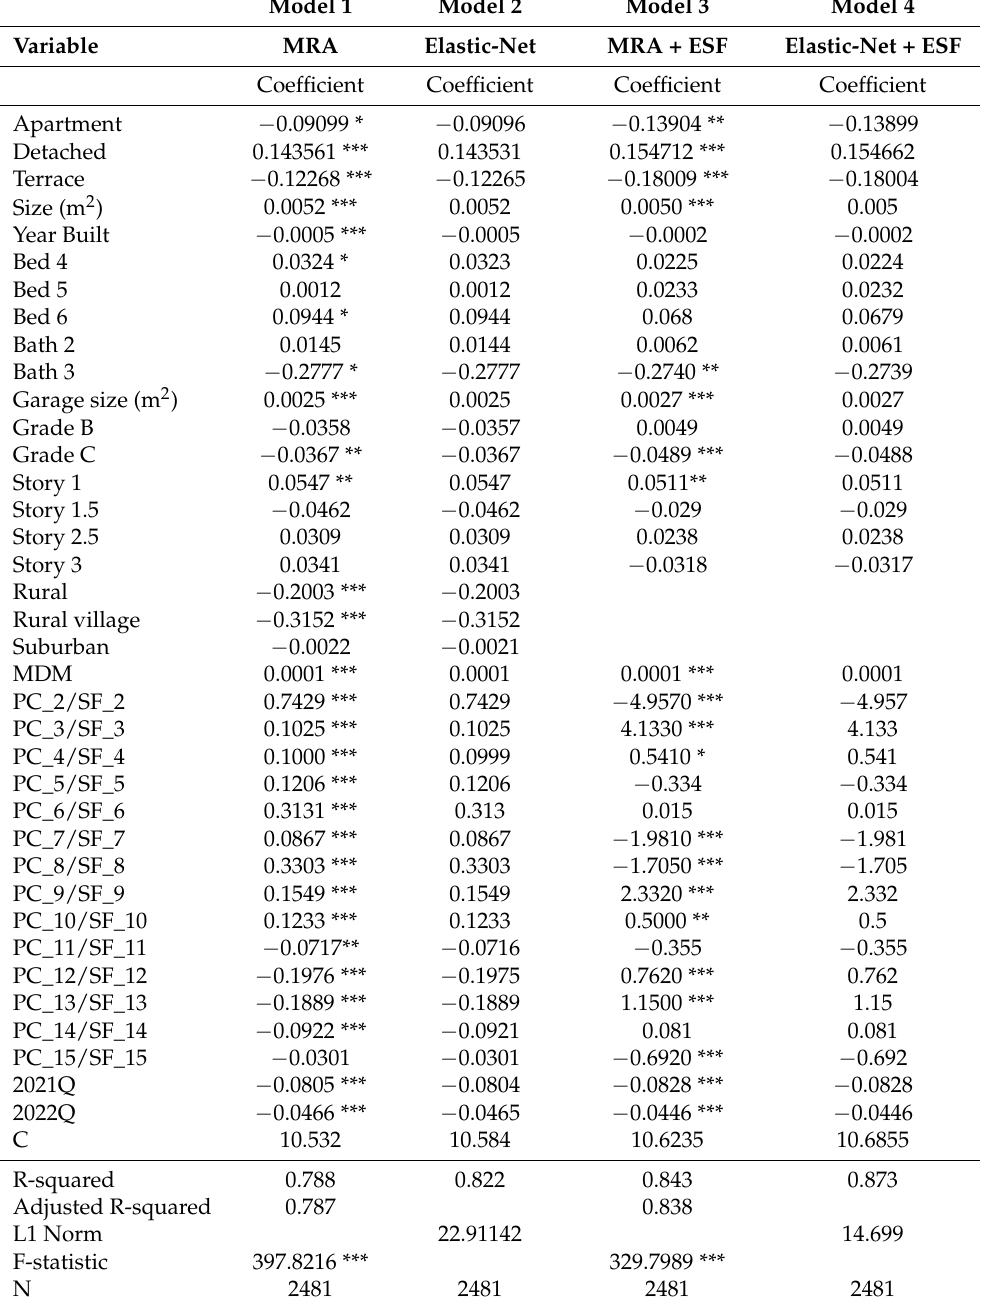
Table 3. Training models level of explanation and